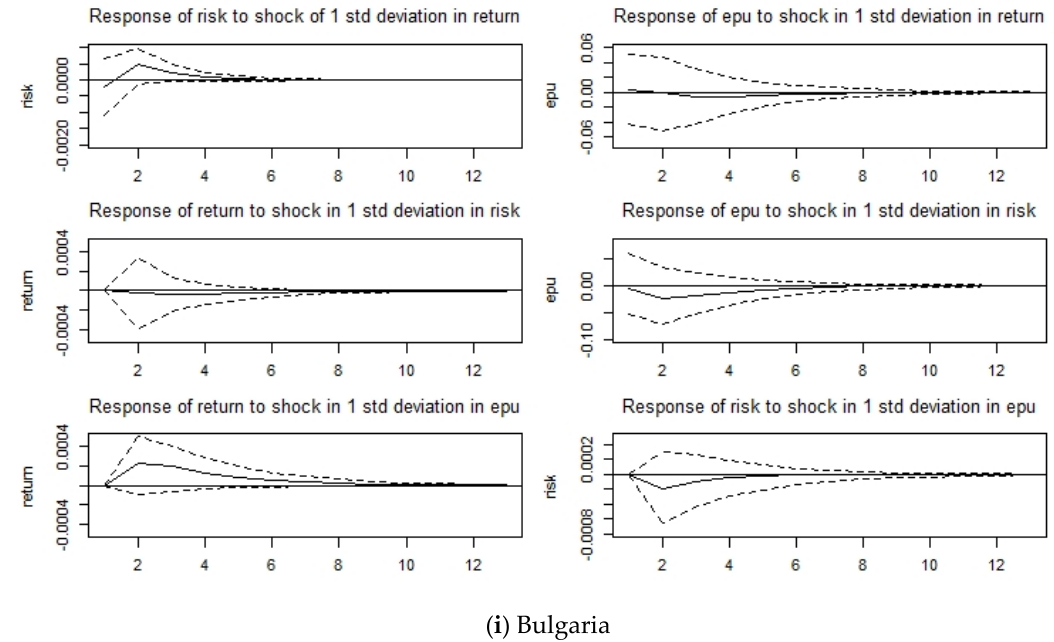
Figure A1. Impulse response functions ( bootstrapped values have been estimated based on 1000 replications ) for every country.